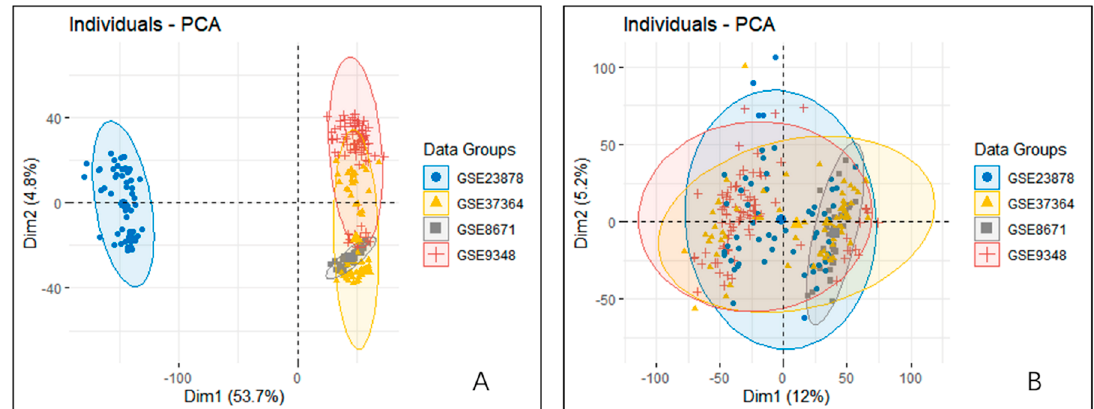
Figure 1. PCA analysis of four datasets before and after the batch effect correction. ( A ) PCA analysis of four datasets before batch effect correction. Dataset GSE23878 was significantly different from the other three datasets; ( B ) PCA analysis of four datasets after batch effect correction. The batch effects of the four datasets were basically eliminated after the correction.